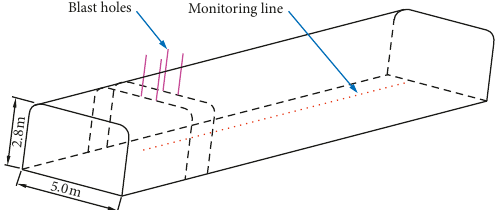
Figure 3: Blasting vibration monitoring in the blasting tests.